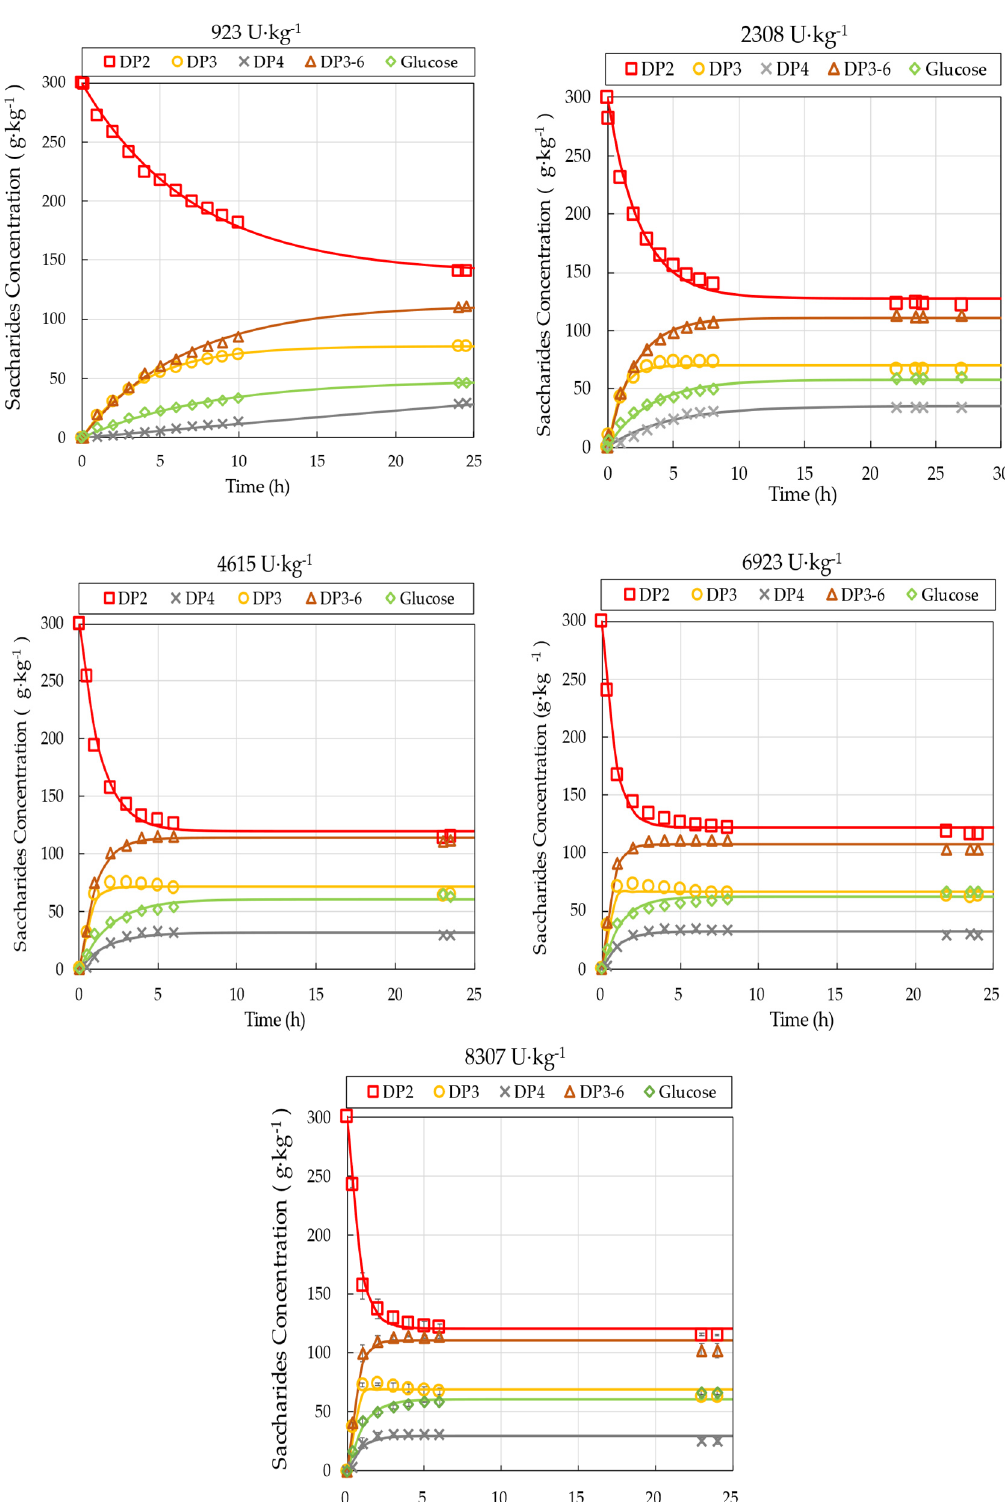
Figure 2. Progress curves of saccharides fractions for various enzyme loads ranging from 923 U·kg − 1 to 8307 U·kg − 1 . Mean values and standard deviation of triplicate measurements are shown for 8307 U·kg − 1 . The solid lines present model predictions (Equation (7)), while symbols represent measured values. Operational conditions: 300 g·kg − 1 initial lactose concentration, pH 6.0, 50 °C, 60 rpm.